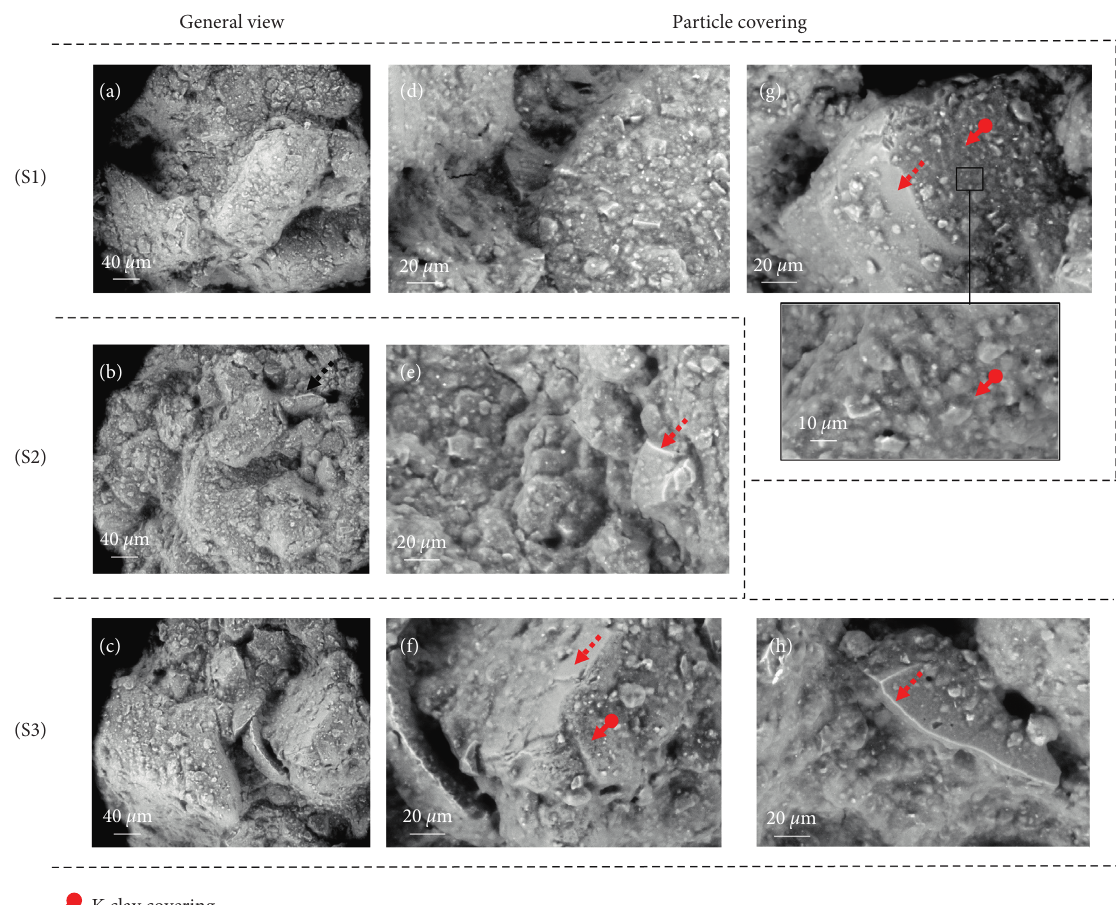
Figure 6: Low magnification views under ESEM of humid (a) S1, (b) S2, (c) S3 samples; high magnifications views of sandy grain boundaries and clay matrix of (d) S1, (e) S2, (f) S3 samples; (g) detailed views of sand boundaries of S1 sample and (h) sand arete in S3